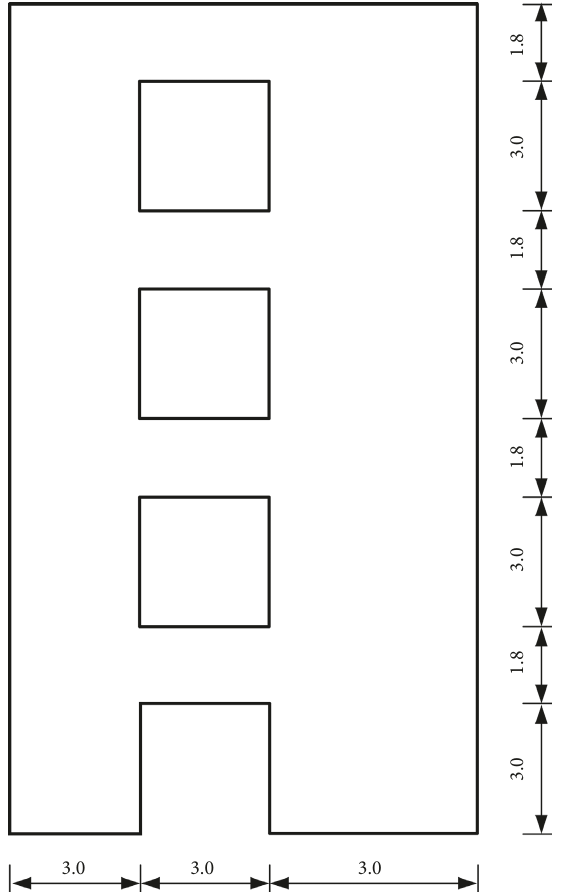
Figure 24: Shear wall with four